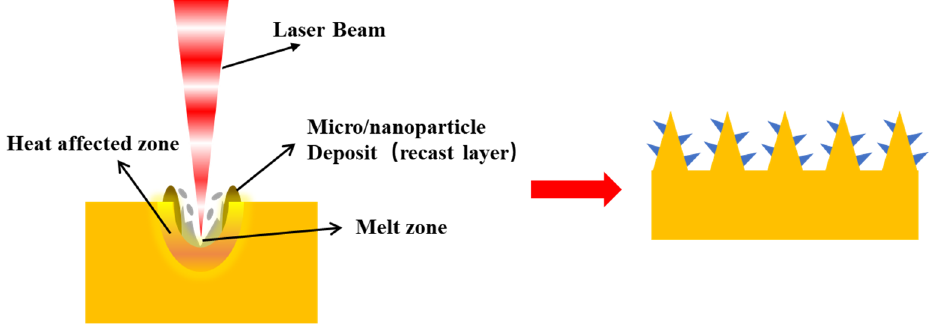
Figure 3. Schematic diagram of laser-prepared microstructures.